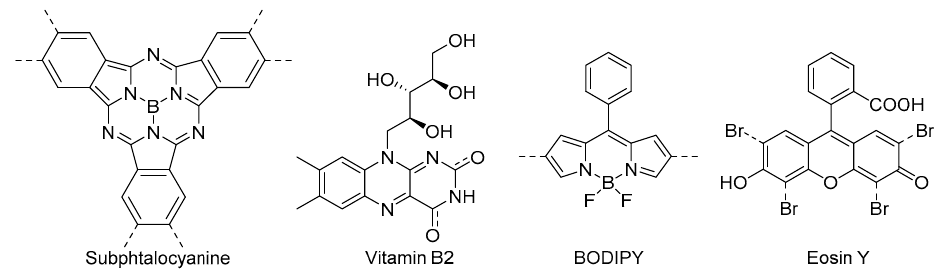
Figure 8. Photosensitizers employed in the functionalization of MOFs.